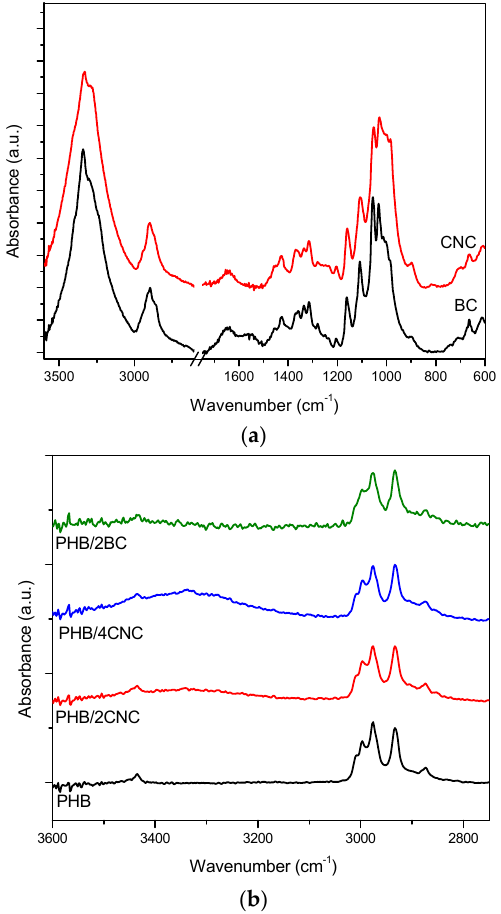
Figure 2. FTIR spectra of CNC and BC ( a ), PHB and PHB nanocomposites with different CNC and BC loading ( b ).